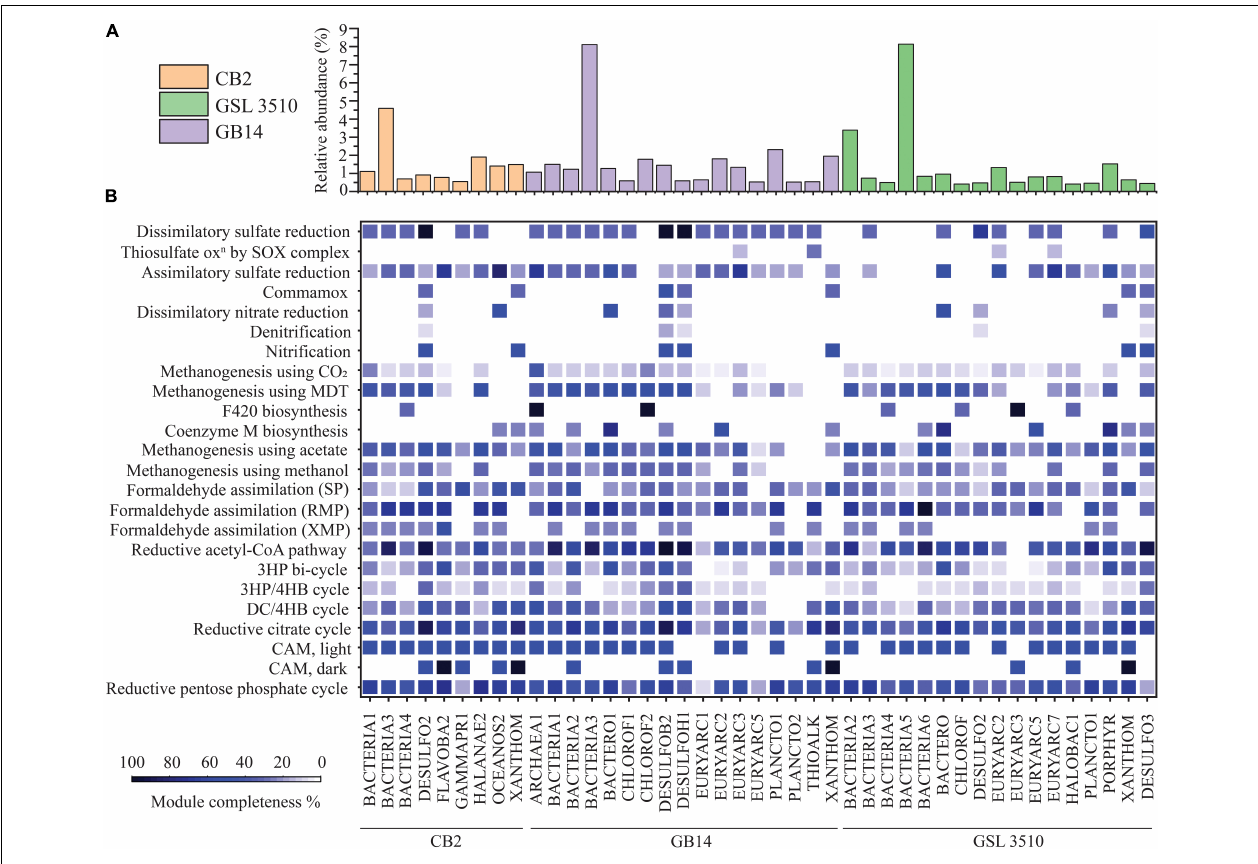
FIGURE 5 | (A) The relative abundance of MAGs across the Great Salt Lake sediments is shown as bar graph. (B) Heatmap representing the percentage completion of KEGG metabolic modules of MAGs selected for phylogenetic analysis (completeness ≥ 50%, contamination < 5%). (MDT, methylamine–dimethylamine–trimethylamine; SP, serine pathway; RMP, ribulose monophosphate pathway; XMP, xylulose monophosphate pathway; 3HP, 3-hydroxypropionate; 3HP/4HB, 3-hydroxypropionate/4-hydroxybutyrate; DC/4HB, dicarboxylate/4-hydroxybutyrate cycle; CAM, Crassulacean acid